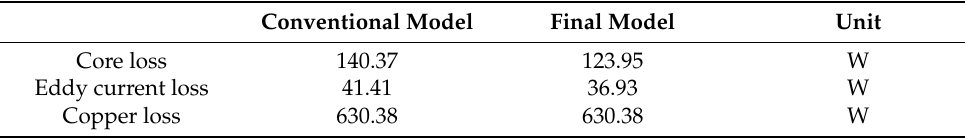
Table 3. Conventional model and final model performance comparison.